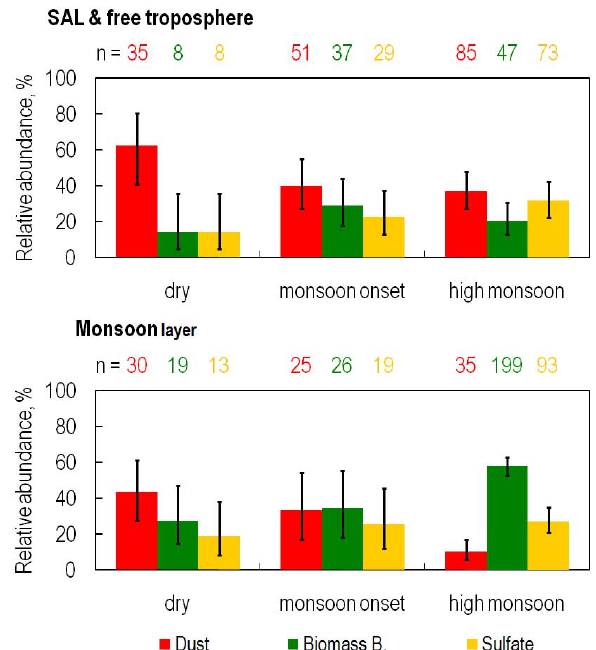
Fig. 9. Relative abundances of mineral dust, biomass burning, and sulfate fractions in submicron particles (Fig. 8) collected in SAL (+ free troposphere) and monsoon layer during the three SOPs. Er- ror bars indicate 95% confidence intervals. Numbers of analyzed particles by TEM-EDX are indicated in corresponding